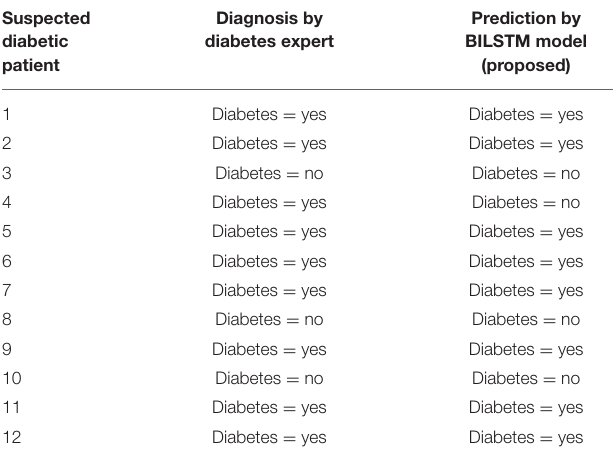
TABLE 9 | The external validation of the proposed method.